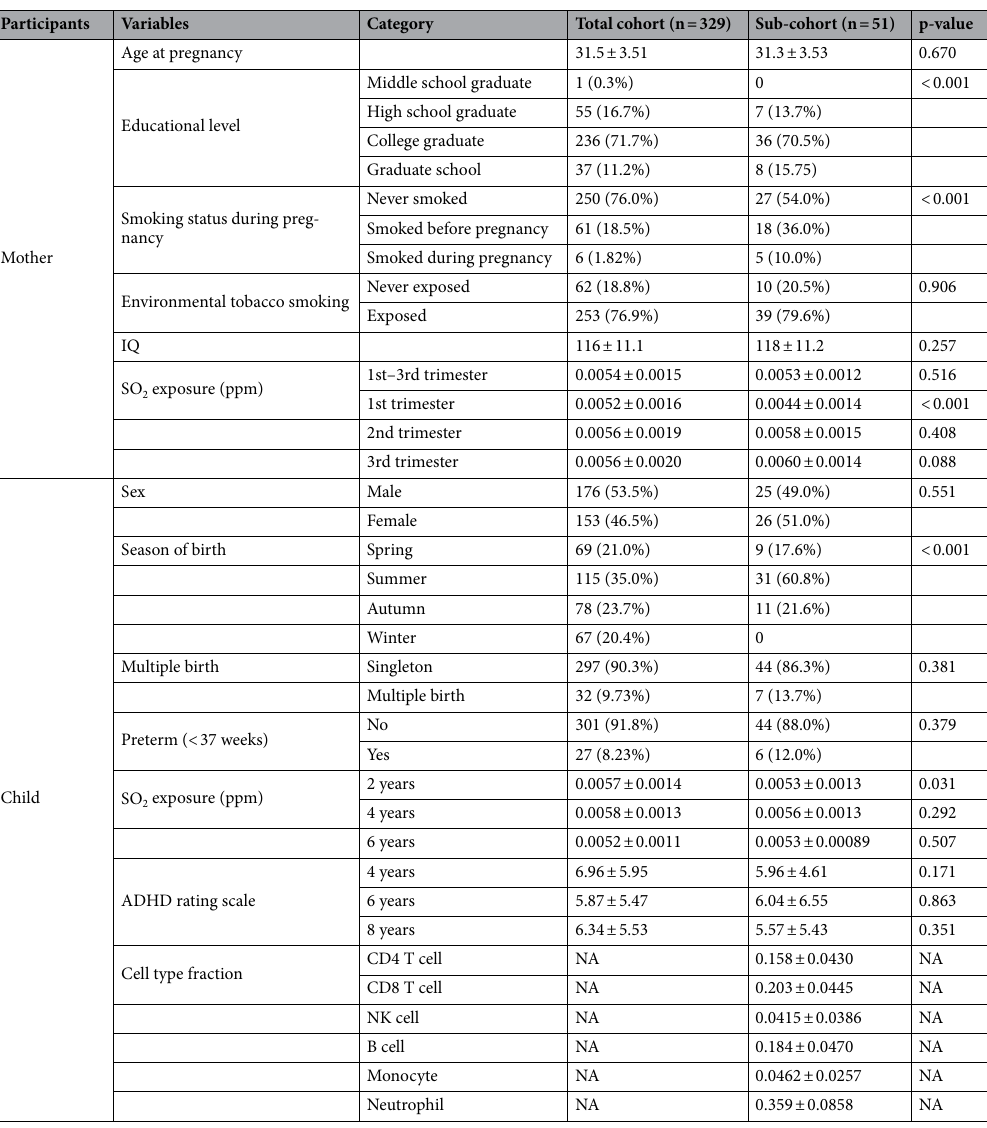
Table 1. General characteristics of study participants.